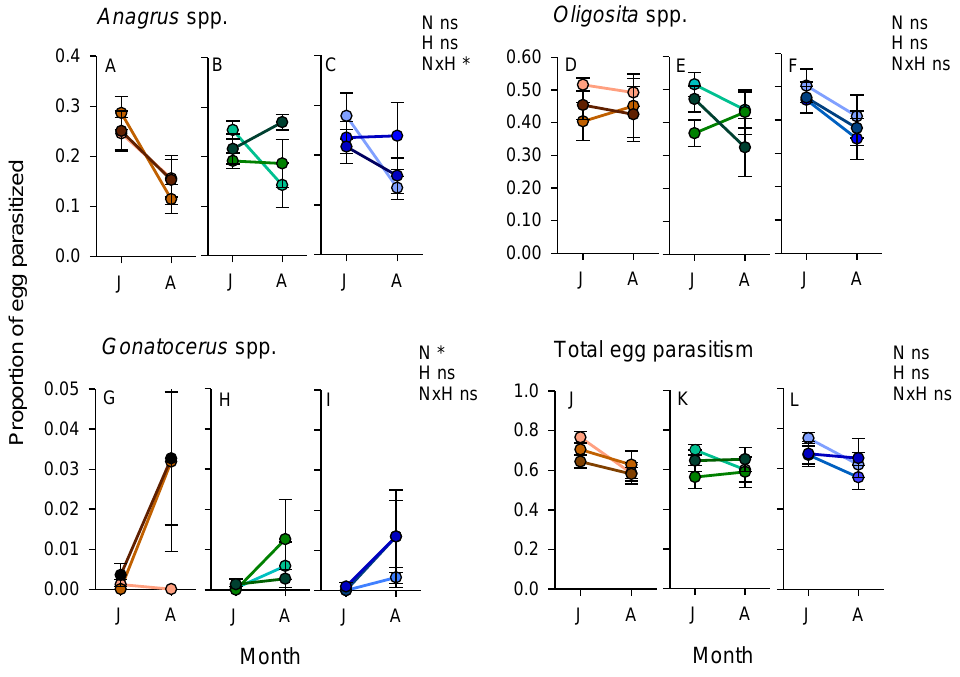
Figure 8. Parasitism of planthopper eggs in rice plants adjacent to clear bunds (brown lines: A, D, G, J), weedy bunds (green lines: B, E, H, K), and sesame bunds (blue lines: C, F, I, L) during July (J) and August (A) of the 2011 wet season crop. Graphs indicate parasitism by Anagrus spp. ( A – C ), Oligosita spp. ( D – F ), and Gonatocerus spp. ( G – I ) as well as the total parasitism ( J – L ). Plots were planted with